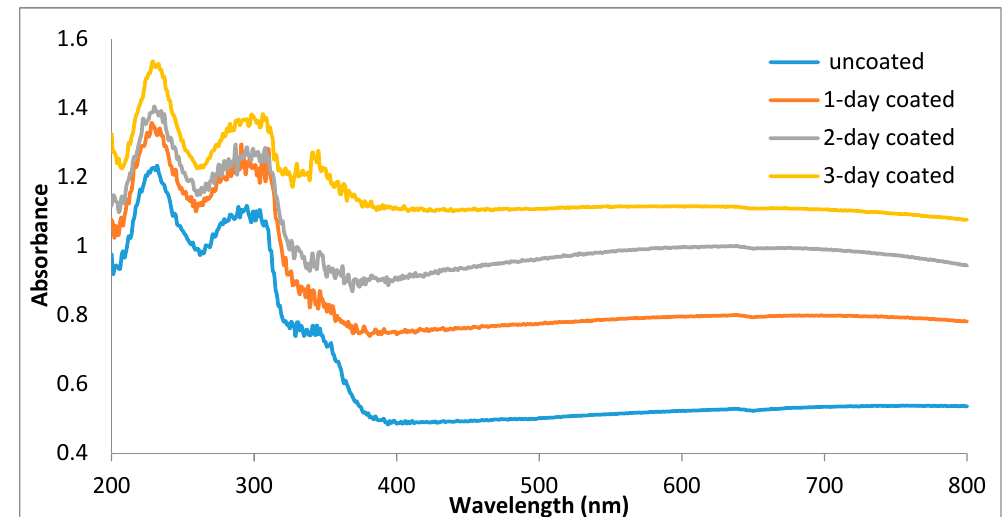
Figure 4. The UV-vis absorbance of uncoated and coated membranes.